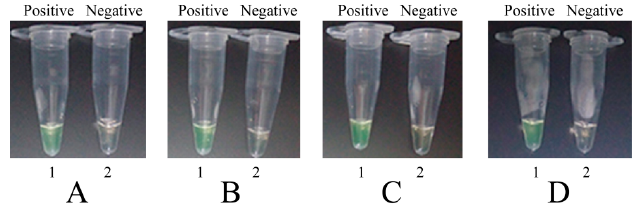
Figure 3. Amplification products of 4 nLAMP assays were visually detected by FD. ( A – D ): nLAMP assay using primers set G1, G2, G3 and G4, respectively. Tube 1, positive amplification, tube 2, negative amplification. Molecules 2015 , 20 , page–page